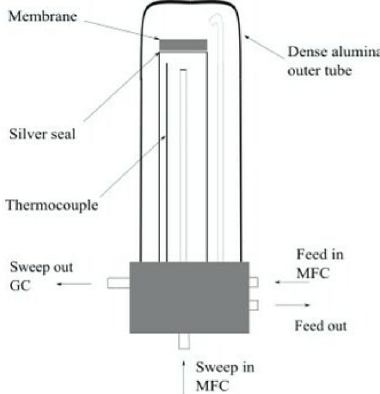
Fig. 2 Schematic representation of the high temperature permeation setup for testing ceramic–carbonate